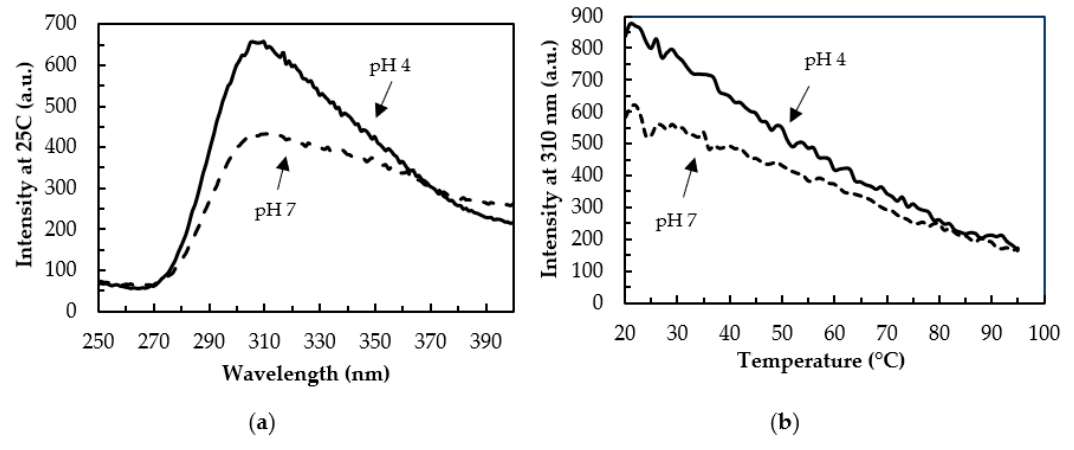
Figure 5. ( a ) Intrinsic tyrosine fluorescence at pH 4 (solid) and 7 (dashed) over 250–400 nm at 25 °C ( b ) Thermal denaturation at pH 4 (solid) and 7 (dashed) monitored by fluorescence emission at 310 nm.